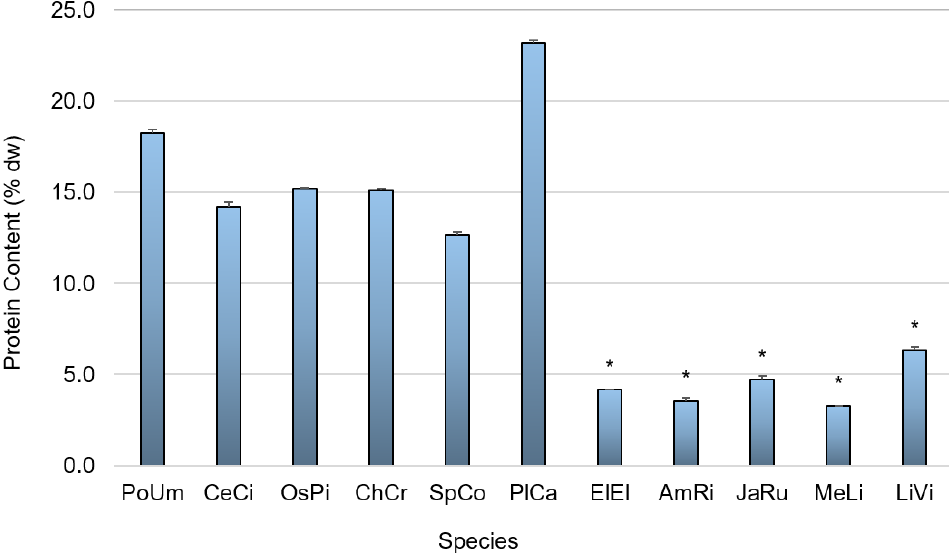
Figure 3. Protein content of the eleven studied red seaweed species expressed in % of dry weight. PoUm: Porphyra umbilicalis , CeCi: Ceramium ciliatum , OsPi: Osmundea pinnatifida , ChCr: Chondrus crispus , SpCo: Sphaerococcus coronopifolius , PlCa: Plocamium cartilagineum , ElEl: Elisolandia elongata ,